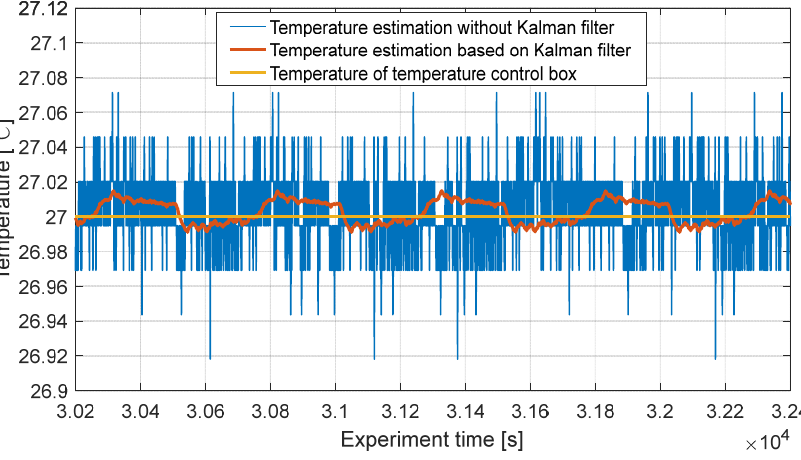
Figure 7. Estimated link temperature for 30,000 – 32,400 s.